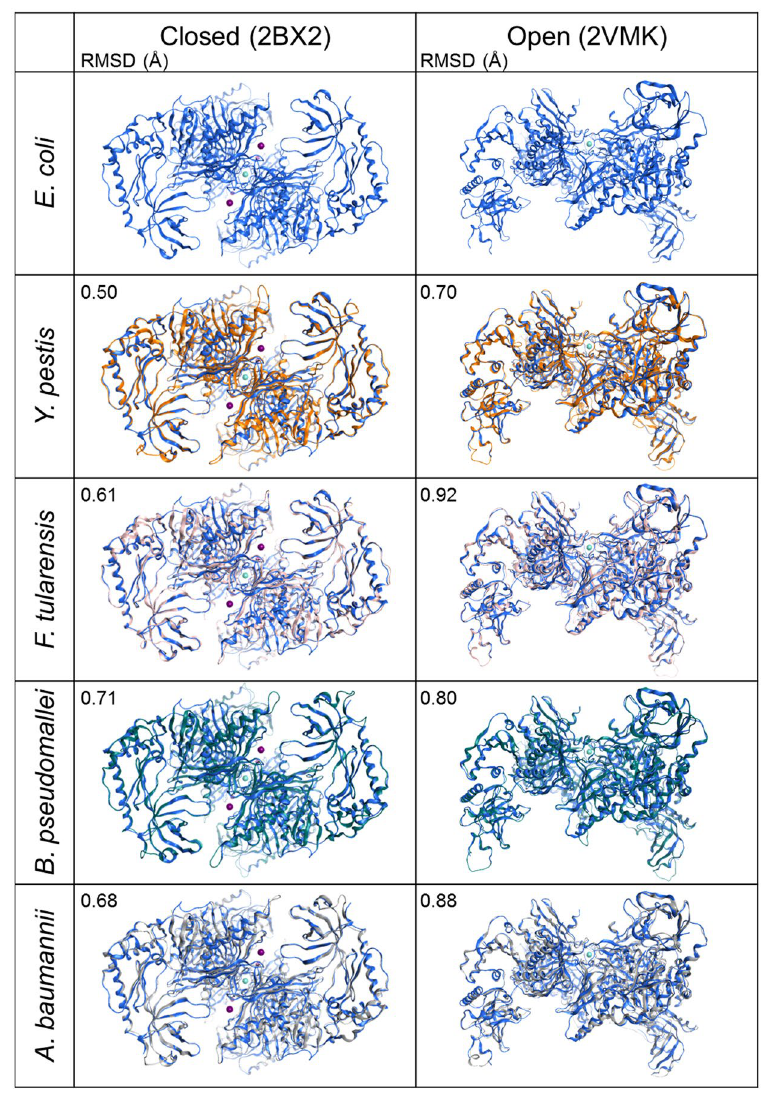
Figure 2. Homology models of RNase E NTDs. Crystal structures of the closed (2BX2) 18 and open (2VMK) 26 conformations of E. coli RNase E NTD (blue ribbons) and homology models of Y. pestis , F. tularensis , B. pseudomallei and A. baumannii RNase E NTDs (various coloured ribbons). The Mg 2 + ions are shown as magenta spheres and the Zn 2 + ions are shown as cyan spheres. The averaged homology models have been overlaid with the E. coli RNase E NTD crystal structure that was used as the template. The RMSD for each homology model in comparison with the template structure is reported in the top left-hand corner of the homology model